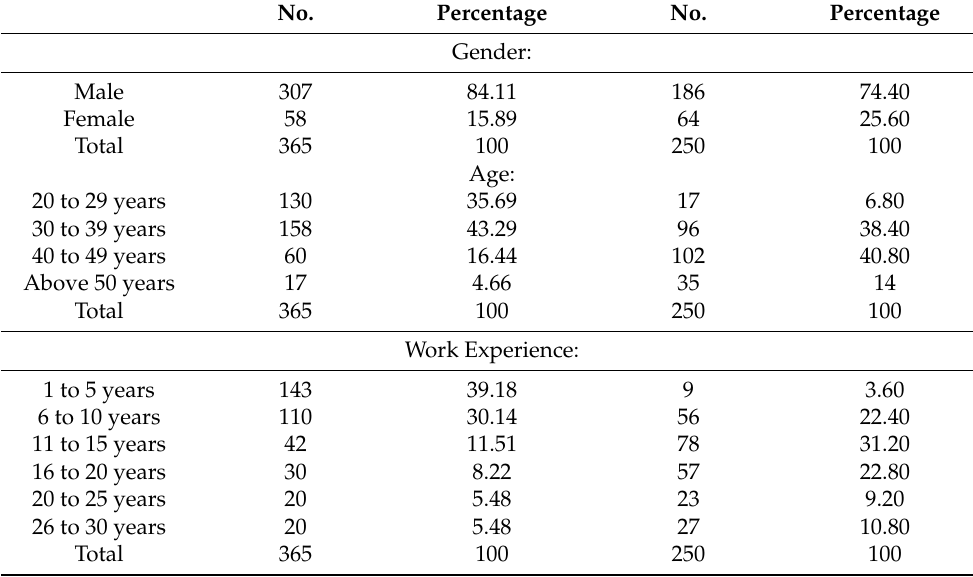
Table 2. The frequency demographic data of Iran and Iraq.